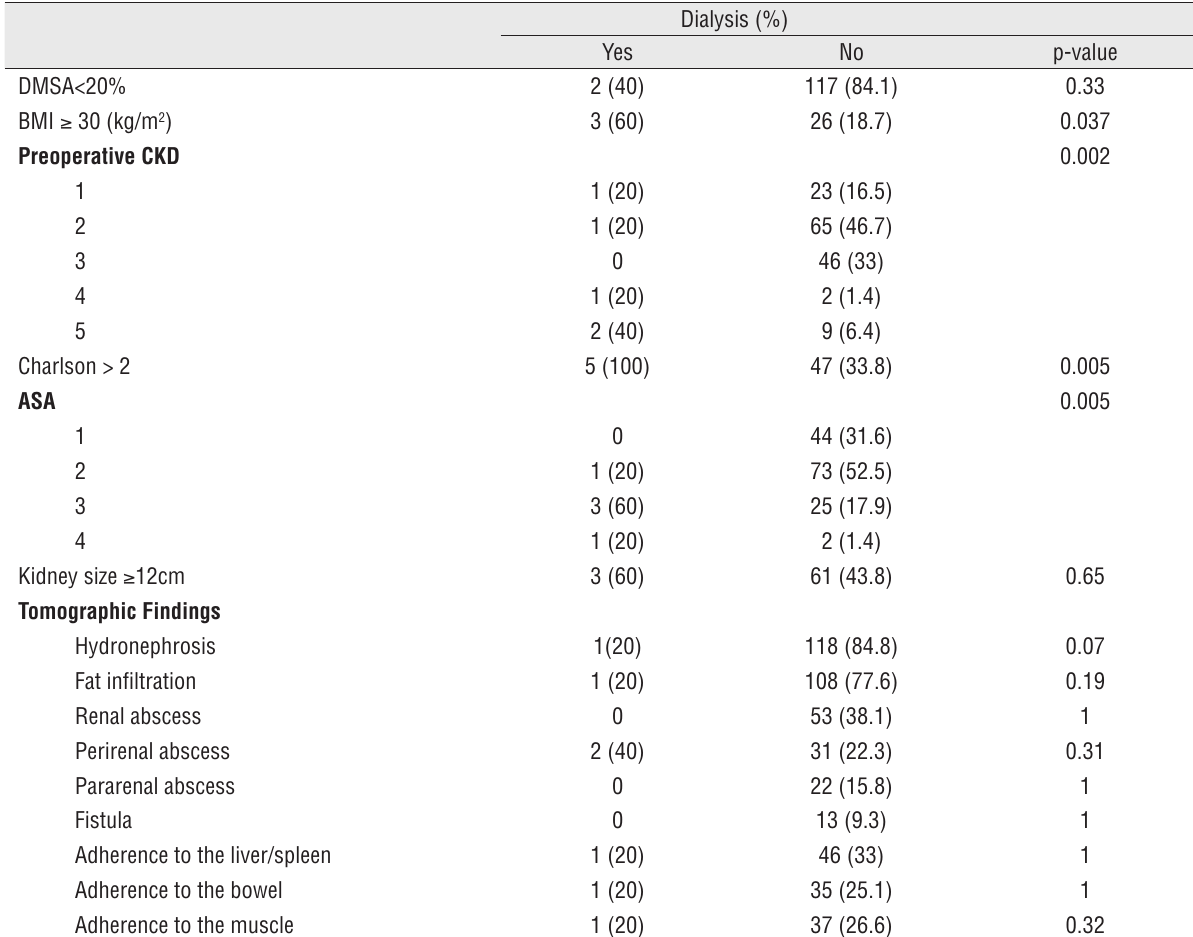
Table 5 - Univariable analysis of risk factors for dialysis in nephrectomy for